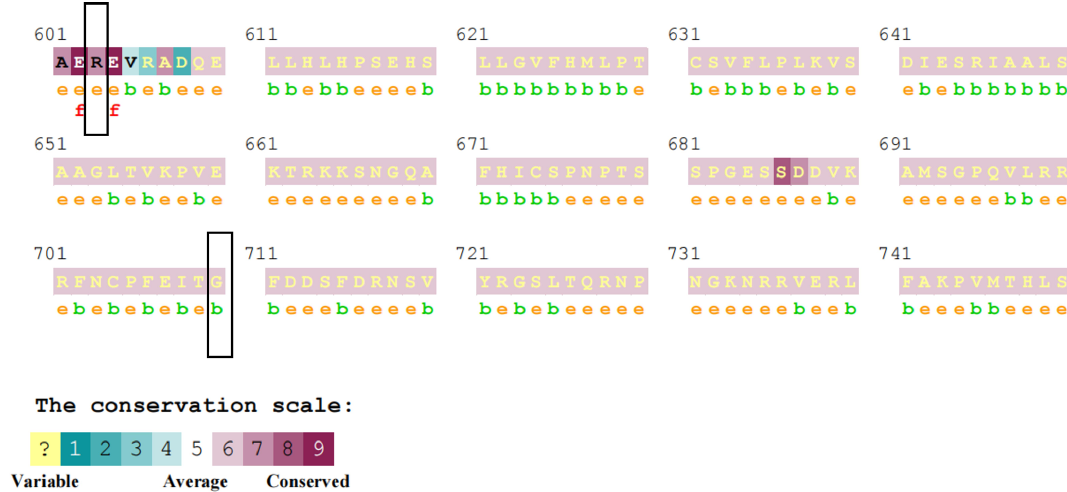
Figure 3. Conservation analysis of the MLPH protein. Different scores output by ConSurf represent different degrees of conservation. The lower the score, the lower the conservation; the higher the score, the higher the conservation. The black boxes represent the two mutation sites of R603S and G710D. Table 4. Correlation analysis of quail MLPH gene polymorphisms and plumage color traits.